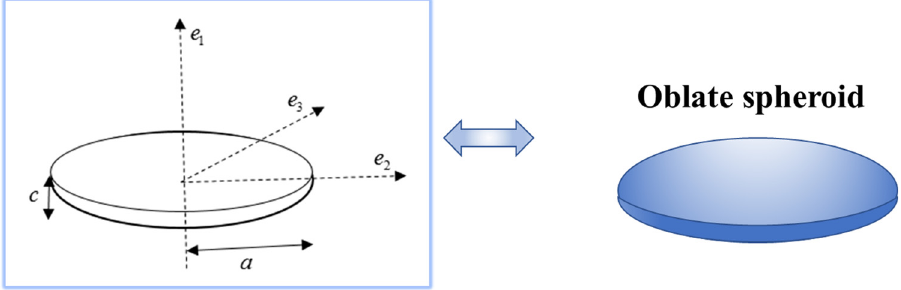
Figure 2: Sketch of the nanosized inclusion and local coordinate system.